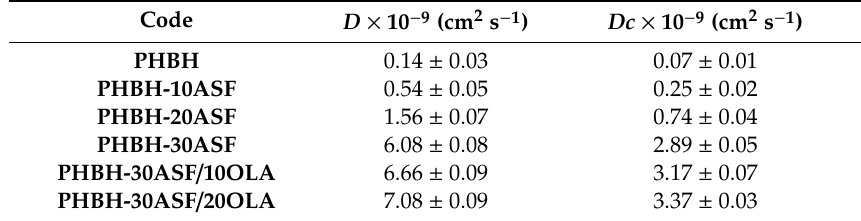
Table 7. Values of the di ff usion coe ffi cient ( D ) and the corrected di ff usion coe ffi cient ( D c ) for PHBH and the PHBH-ASF composites processed with